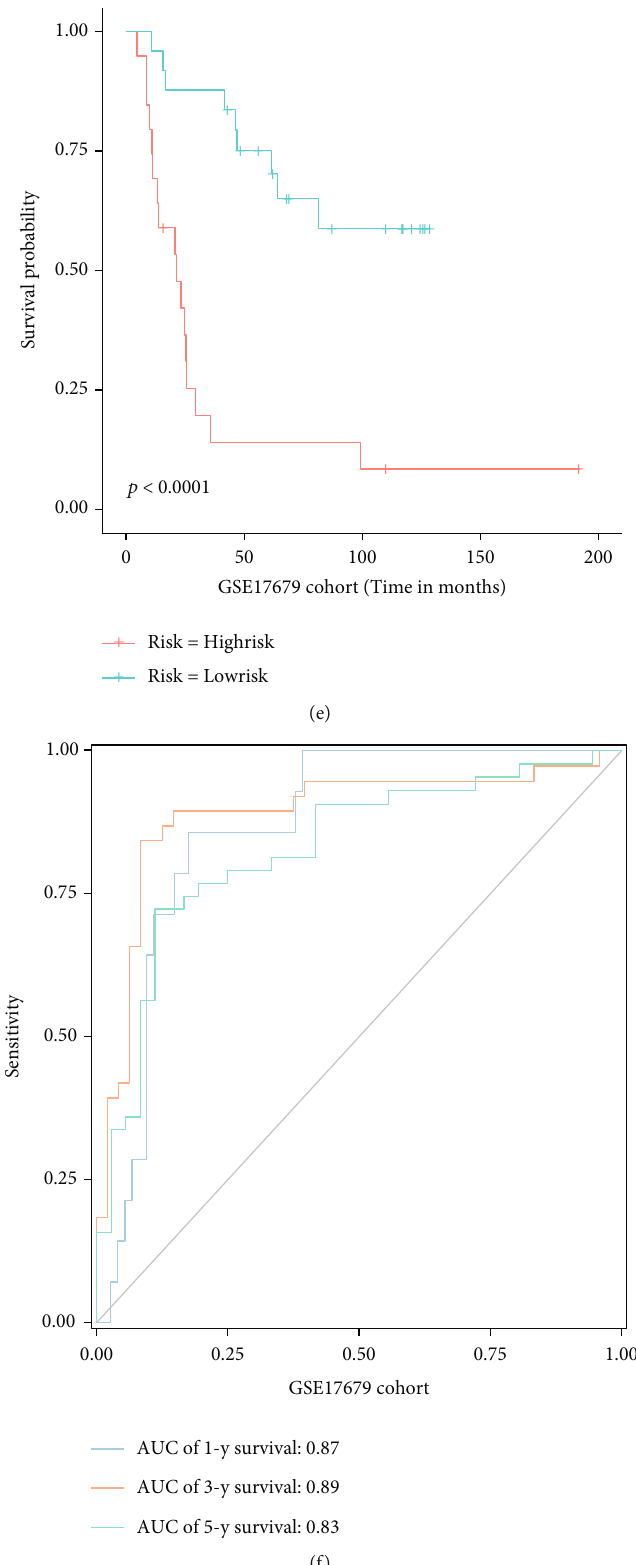
Figure 3: Evaluation of the performance of the gene signature by internal validation cohorts. In train cohort, test cohort, and entire GSE17679 cohort: Kaplan-Meier curves (a, c, e) and ROC curves (b, d,